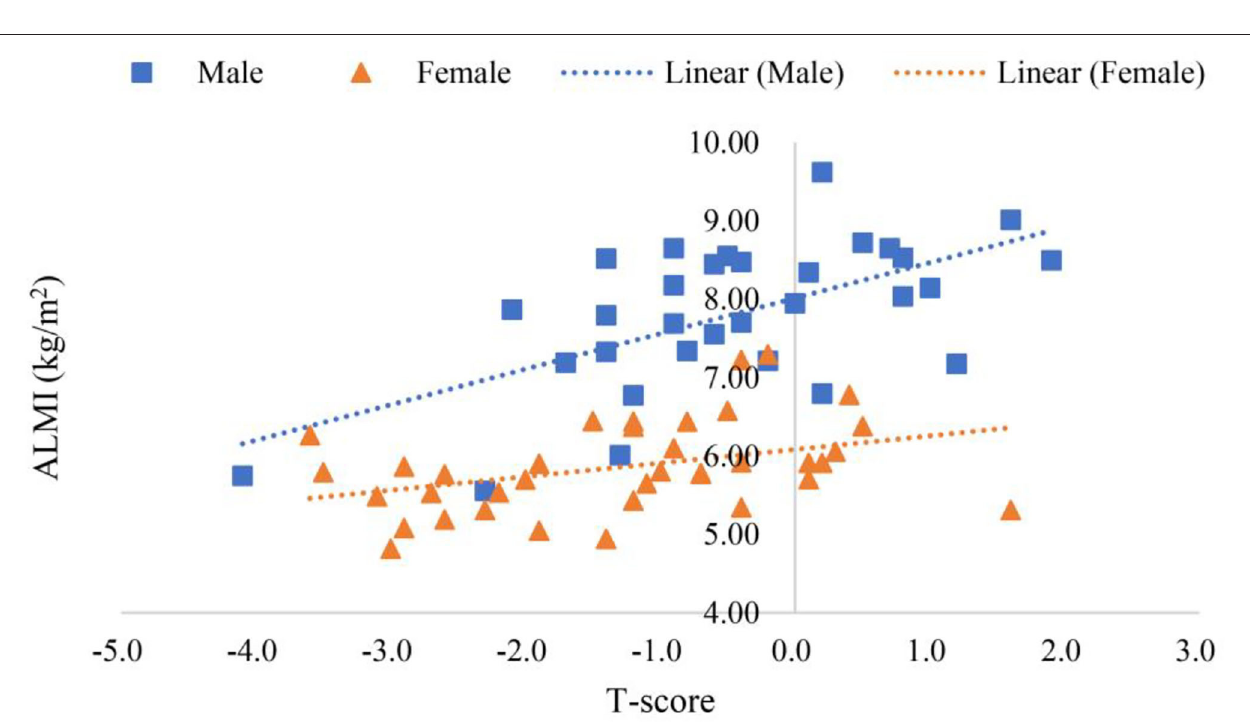
FIGURE 8 | Scatter plots of participants’ ALMI and T